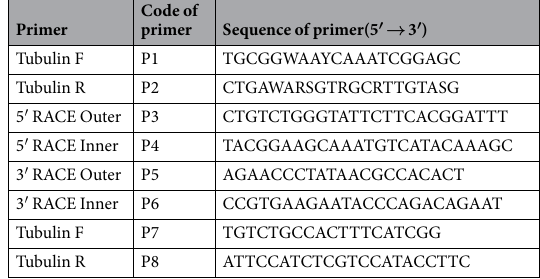
Table 1. Primers designed for coloning β - tubulin gene from S. chinensis